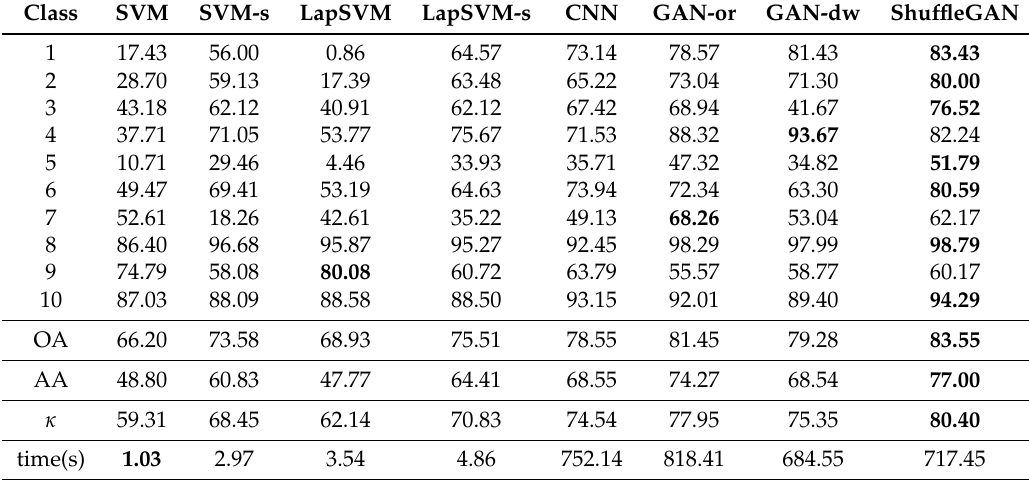
Table 4. Classification accuracy (%) of various methods for the Haizhu Lake wetland data, bold values indicate the best result for a